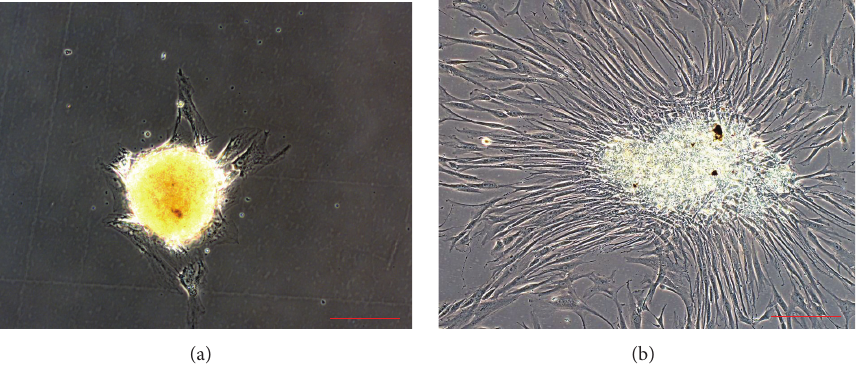
Figure 8: Sarcosphere after isolation. (a) Sarcospheres from OSA3 cell lines showed a beginning of adherent expansion by reintroduction and reculturing in monolayer, adherent conditions at 48 hours from the isolation. (b) At 7 days after the isolation sarcospheres showed adherent expansion by reintroduction and reculturing in monolayer, adherent conditions. Observation in phase contrast. Original magnification: 20x. Bar size: 100 𝜇 m.